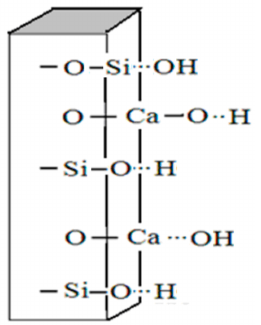
Figure 9. Surface components of wollastonite.